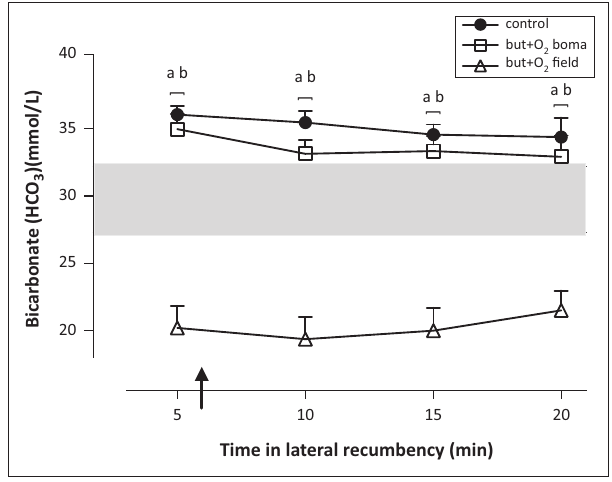
FIGURE 2: Bicarbonate concentration (HCO